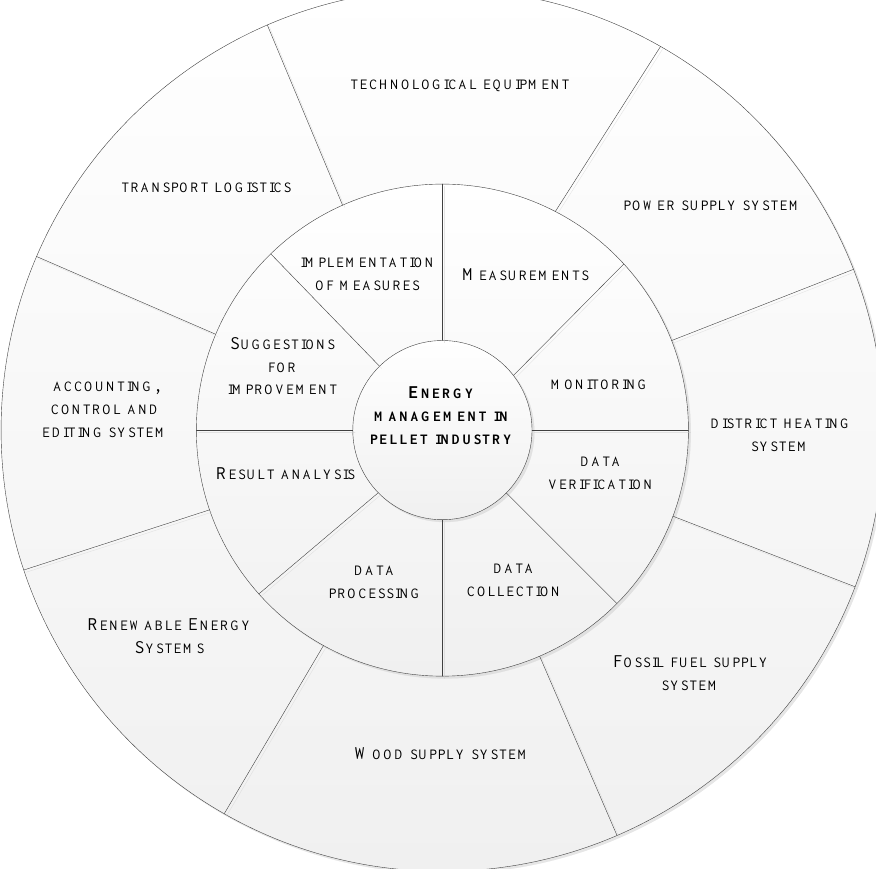
Fig. 1. Demand side management scheme with internal and external